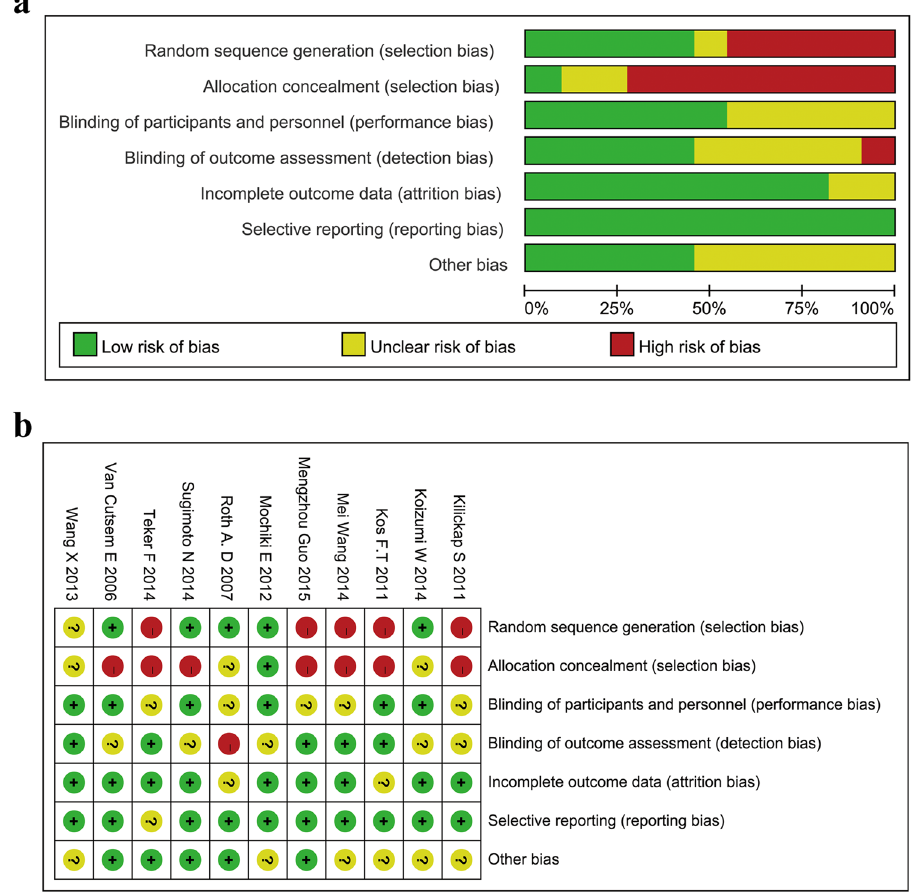
Figure 2. Risk of bias graph and summary of